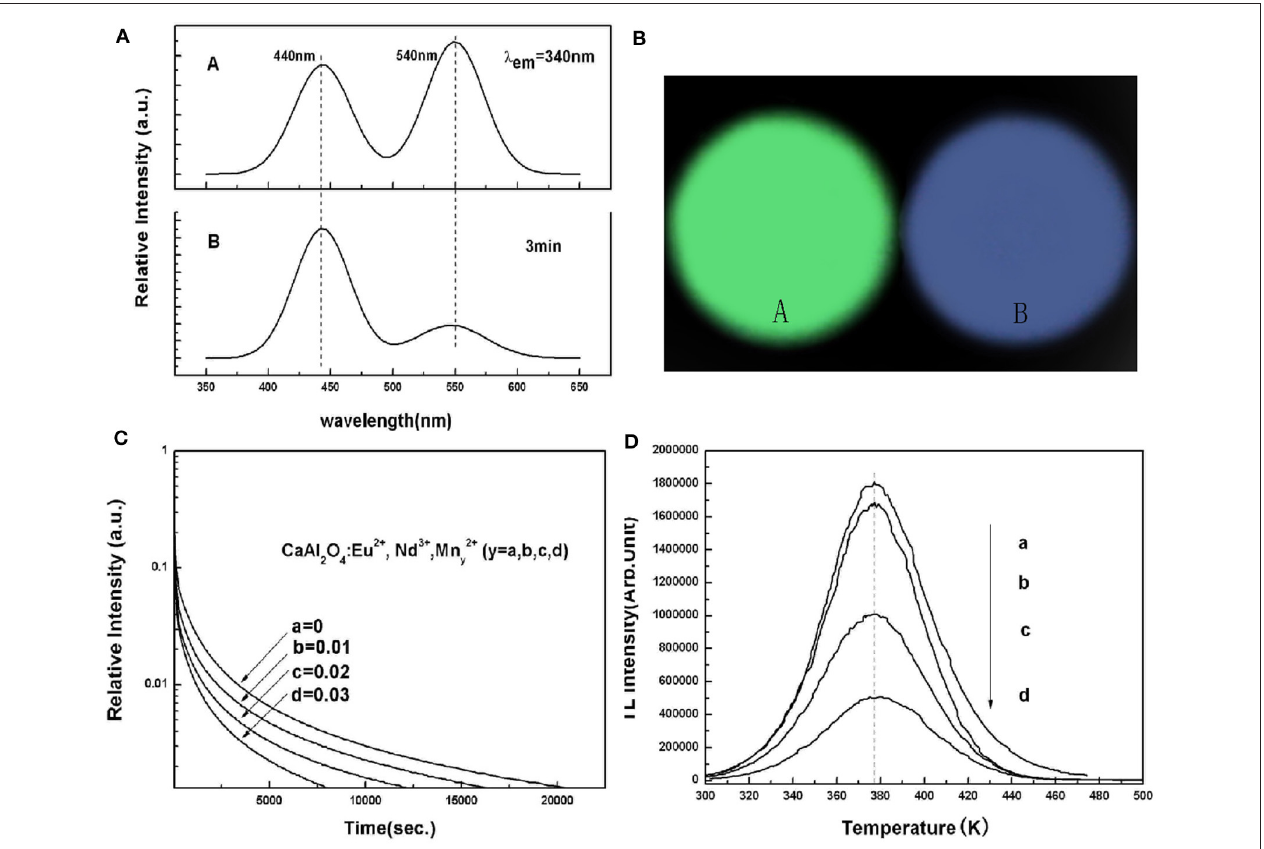
FIGURE 6 | (A) PL and LPL spectra of CaAl 2 O 4 : xEu 2 + , 2xNd 3 + , yMn 2 + ( x = 0.00125, y = 0.03). (B) Photographs of PL and LPL of CaAl 2 O 4 : xEu 2 + , 2xNd 3 + , yMn 2 + ( x = 0.00125, y = 0.03). (C) LPL decay curves, and (D) TL curves of Ca 1 − 3x − y Al 2 O 4 : xEu 2 + , 2xNd 3 + , yMn 2 + ( x = 0.00125, 0 ≤ y ≤ 0.03). Rights managed by AIP